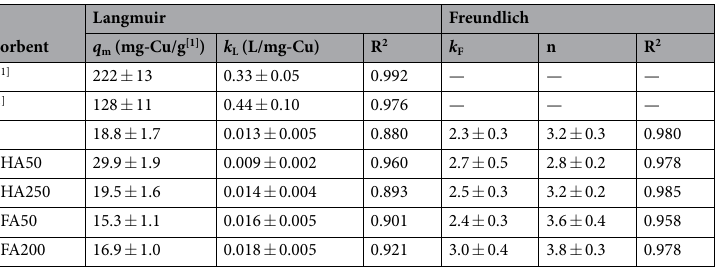
Table 2. Isotherm parameters for Cu 2 + binding to DOM and adsorption on biochar. [1] For HA and FA, g represents